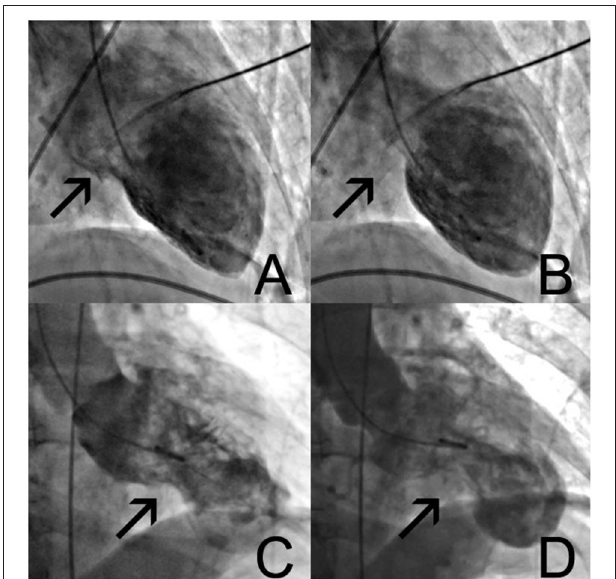
FIGURE 2 | Left ventricular ventriculography (A–D) . In normal diastole (A) , with typical apical ballooning and contraction of only the basal parts of the ventricle (B) . Control angiogram after readmission 7 days later (C) , showing different morphologies with mid-section hypercontraction and apical sparing (D) . See also Supplementary Data Clips 1 , 2